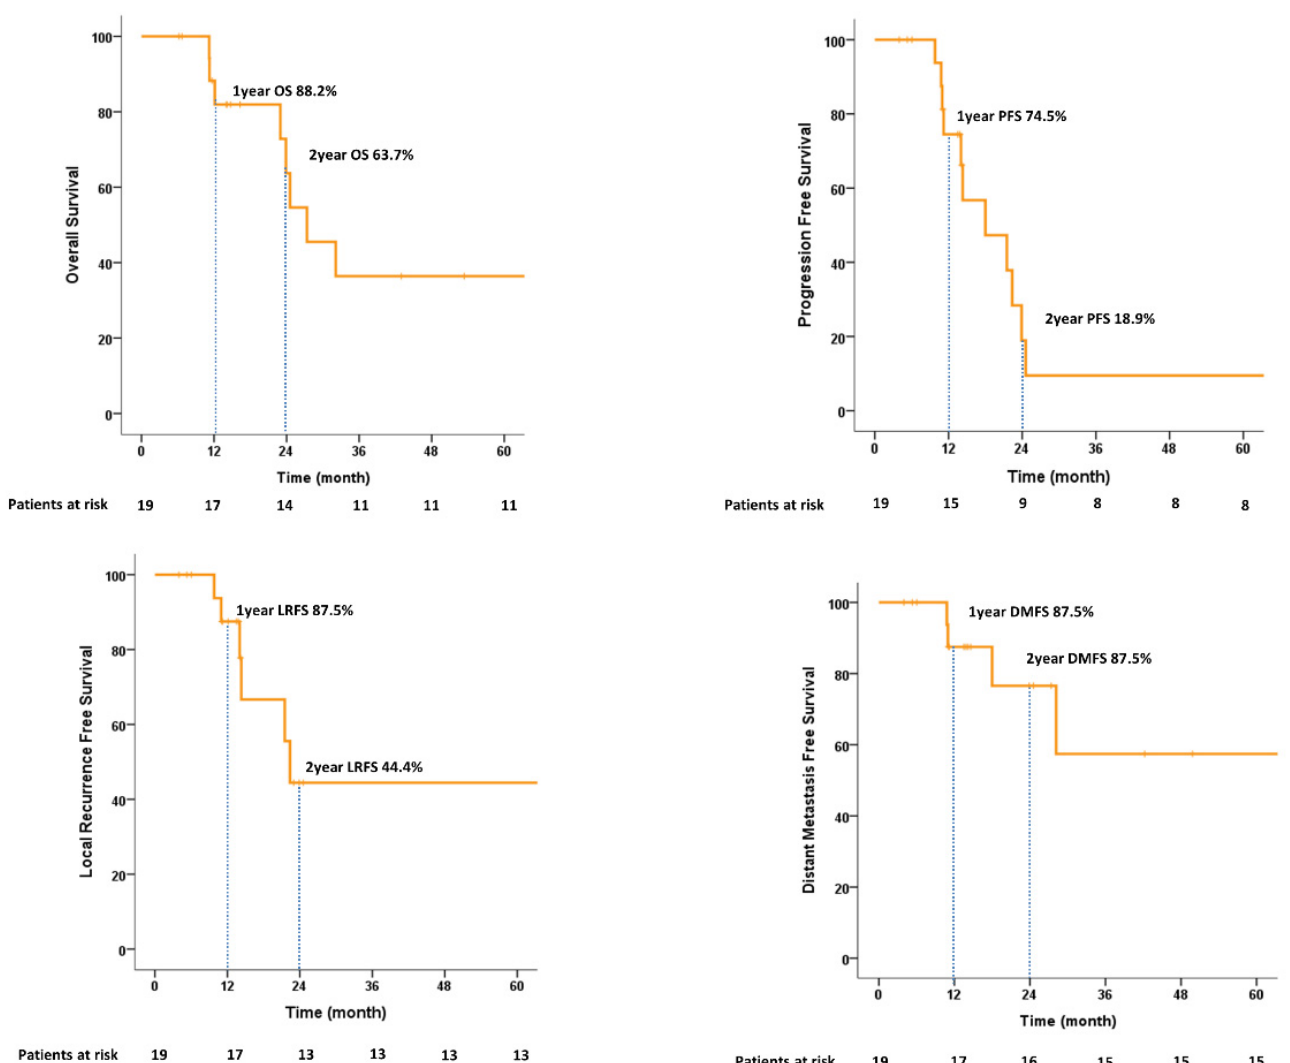
Figure 4. Kaplan–Meier estimates of overall survival, progression-free survival, local recurrence-free survival, and distant metastasis-free survival.